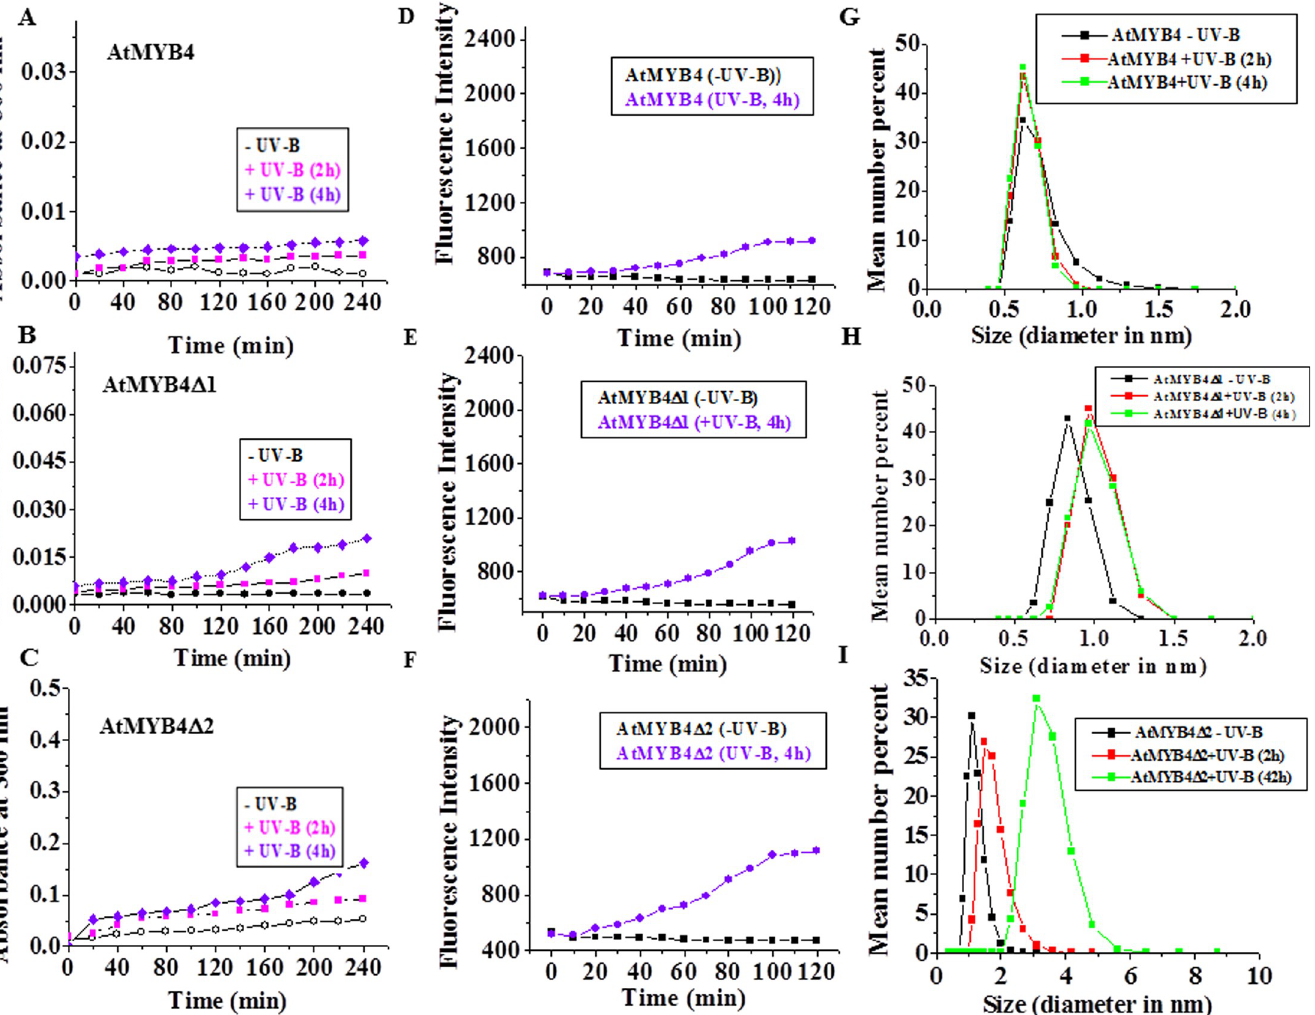
Fig 7. Analysis of the possibility of UV-B induced aggregation of AtMYB4 in vitro . A-C Aggregation assay using untreated control, 2h and 4h UV-B irradiated purified recombinant AtMYB4 (A), AtMYB4 Δ 1 (B) and AtMYB4 Δ 2 (C) proteins in UV-B spectrophotometer. D-F.Fluorescence spectra of untreated control and 4h UV-B irradiated purified recombinant AtMYB4 (D), AtMYB4 Δ 1 (E) and AtMYB4 Δ 2 (F) proteins. G-I. Aggregation assay by measurement of dynamic light scattering patterns of untreated control, 2h and 4h UV-B irradiated purified recombinant AtMYB4 (G), AtMYB4 Δ 1 (H) and AtMYB4 Δ 2 (I)proteins.